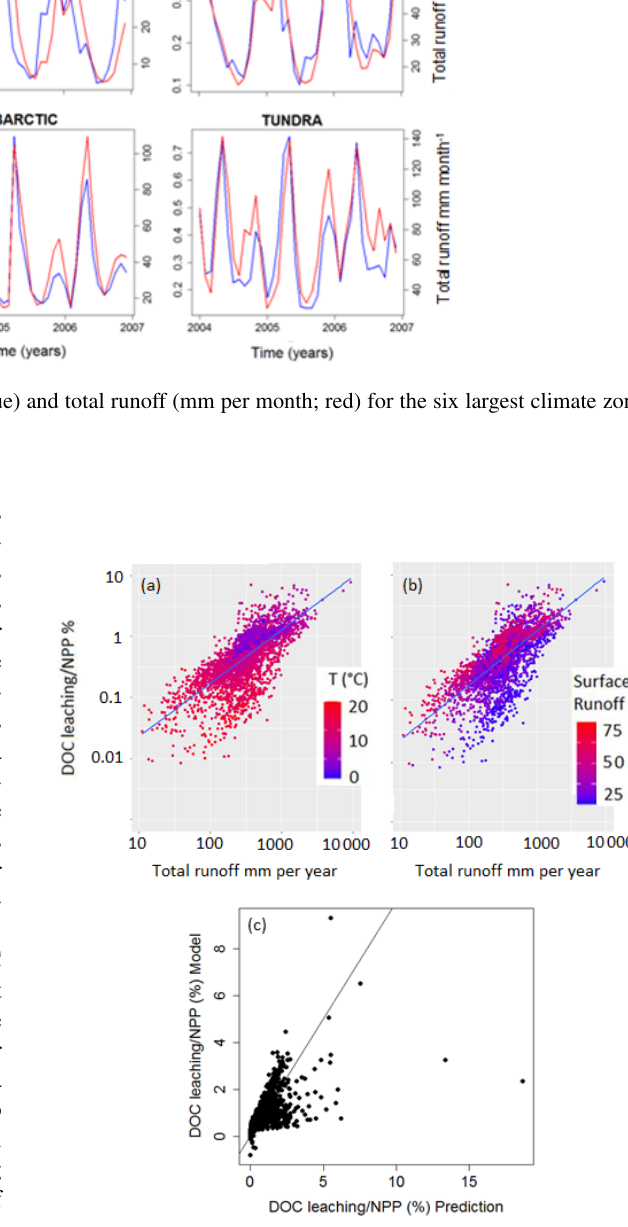
Figure 13. Fraction (%) of terrestrial NPP that is leached as DOC into the river network as a function of total runoff. Each point repre- sents the grid-cell average of both metrics for the entire simulation period (1979–2006). In panel (a) the color scale represents the grid- cell average temperature ( ◦ C) while in panel (b) , the color scale represents the ratio of surface runoff to total runoff in percentage. Panel (c) shows the normalized predicted ratio of DOC leaching flux to NPP (Eq. 13) against the normalized simulated